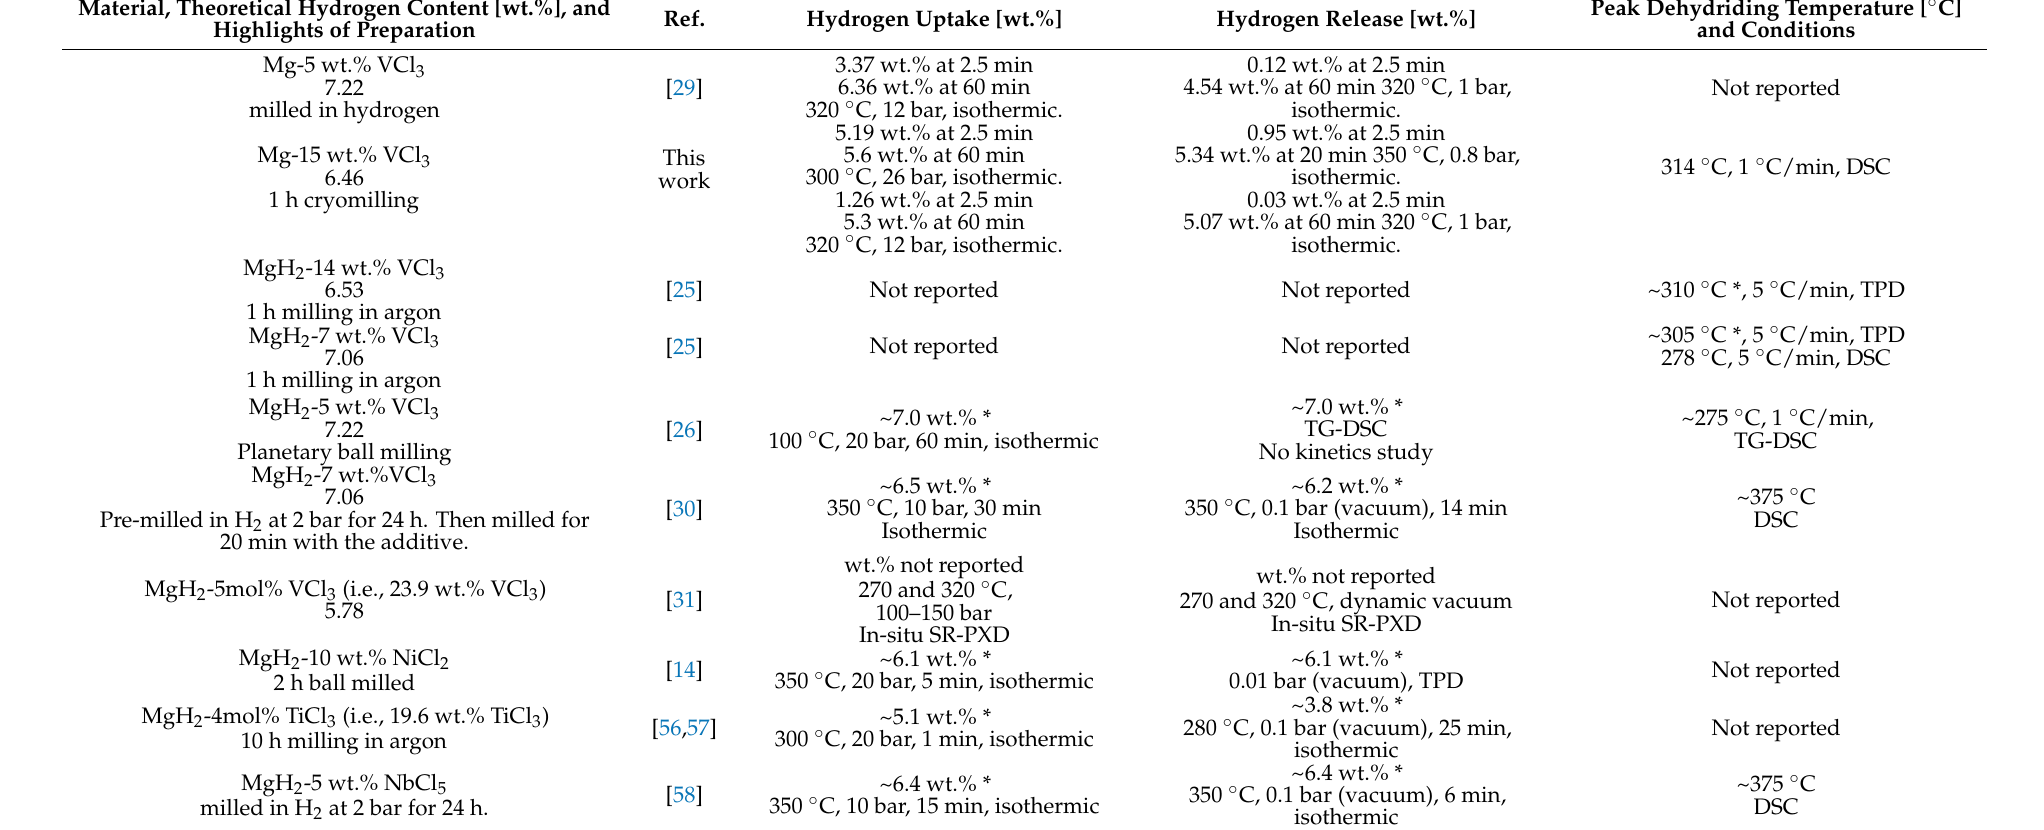
Table 3. Comparison of material composition, preparation, hydrogen uptake and release, and dehydriding temperature of reported Mg/MgH 2 -VCl 3 and other mixtures. Material, Theoretical Hydrogen Content [wt.%], and Highlights of